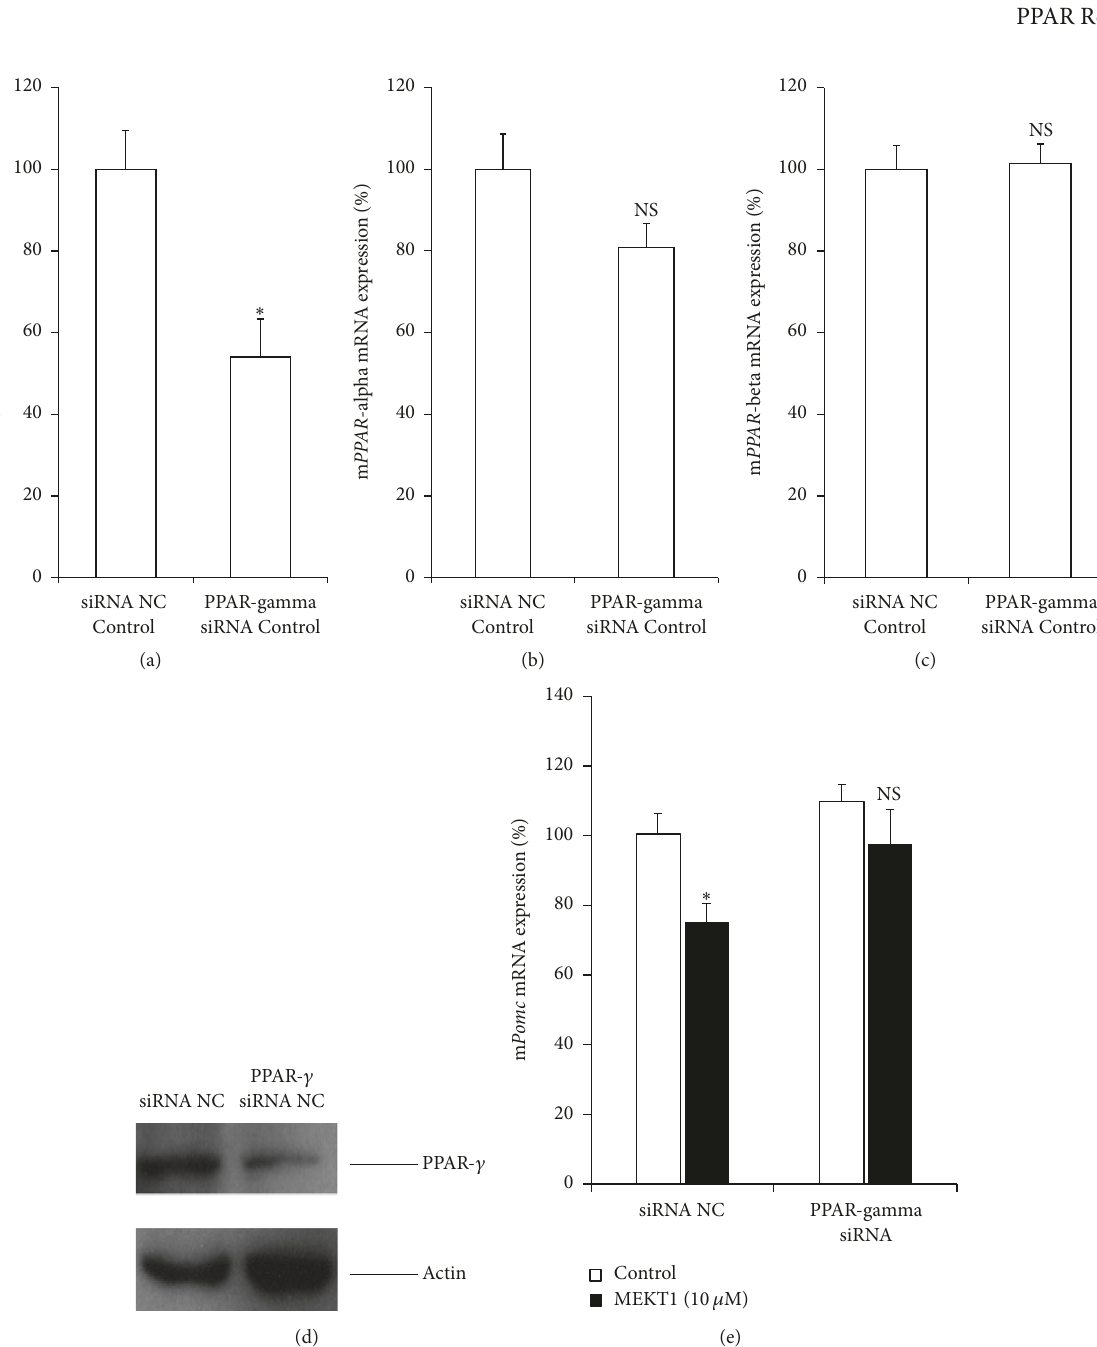
Figure 5: Involvement of PPAR- 𝛾 in the MEKT1 effects on Pomc mRNA expression. Effects of PPAR- 𝛾 knockdown by its siRNA on (a) PPAR- 𝛾 mRNA expression, (b) PPAR- 𝛼 mRNA expression, and (c) PPAR- 𝛽 mRNA expression. AtT20 cells transiently transfected with siRNA (negative control; NC or PPAR- 𝛾 ) for 48 hours were incubated with 0.1% DMSO (control) for 24 hours. Results are expressed as percentages of each control. Each point represents mean ± SEM ( 𝑛 = 4 ). ∗ 𝑃 < 0.05 versus basal negative control siRNA. NS stands for “not significant.” (d) Effects of PPAR- 𝛾 knockdown by its siRNA on the PPAR- 𝛾 protein expression. (e) Effects of PPAR- 𝛾 knockdown by its siRNA on the Pomc mRNA expression. AtT20 cells transiently transfected with siRNA (negative control; NC or PPAR- 𝛾 ) for 48 hours were incubated in the presence of either MEKT1 (10 𝜇 M) or 0.1% DMSO (control) for 24 hours, respectively. Data are expressed as percentages (100%) of control. Each point represents mean ± SEM ( 𝑛 = 4 ). NS stands for “not significant.” ∗ 𝑃 < 0.05 versus negative control siRNA at 10 𝜇 M